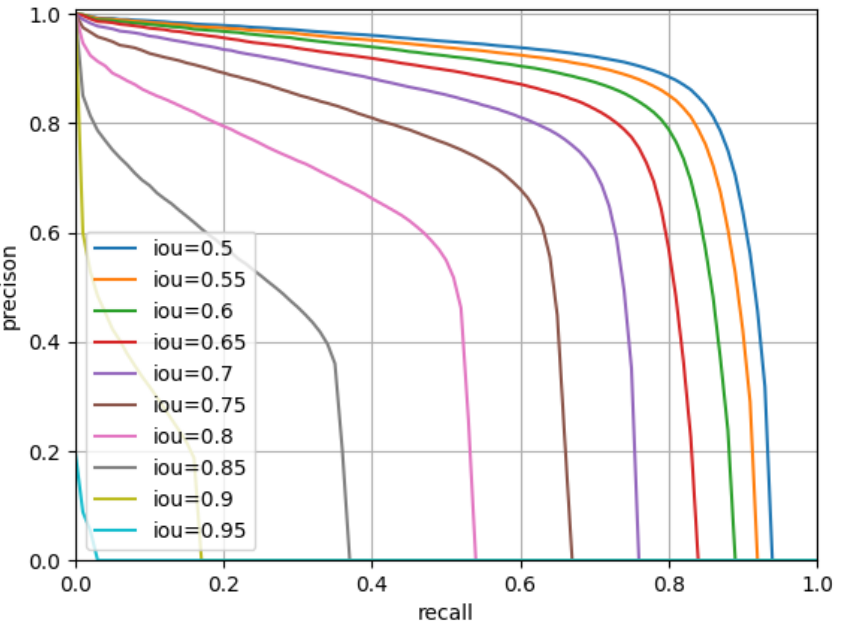
Figure 15. The PR curves of category building on AIBD. The AIBD contains only one category: building. These curves are achieved by the EFNet as the different IoU s between the predicted boxes and the